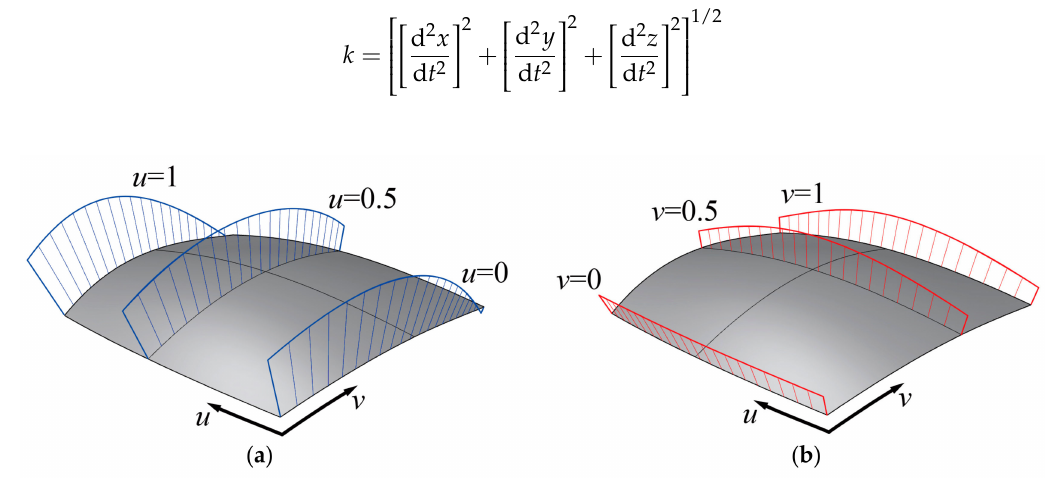
Figure 8. Some key isocurves of a surface are used to define the surface curvature: ( a ) The isocurves u = 0, 0.5, 1 in direction- u ; ( b ) The isocurves v = 0, 0.5, 1 in direction- v